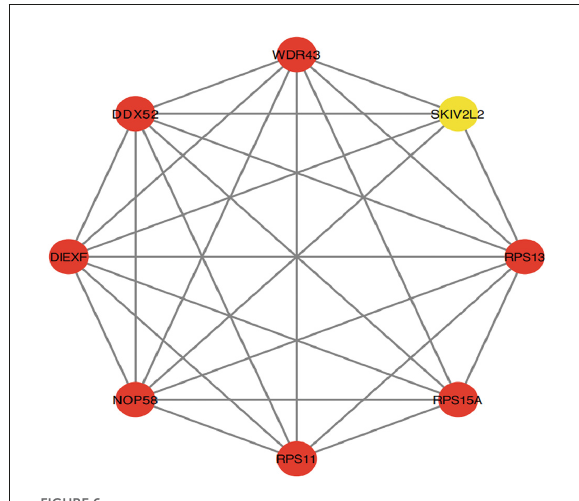
FIGURE6 Protein-protein interaction (PPI) network constructed using the STRING database. The eight genes with the most connectivity under Molecular Complex Detection Algorithm (MCODE) were visualized using Cytoscape software.